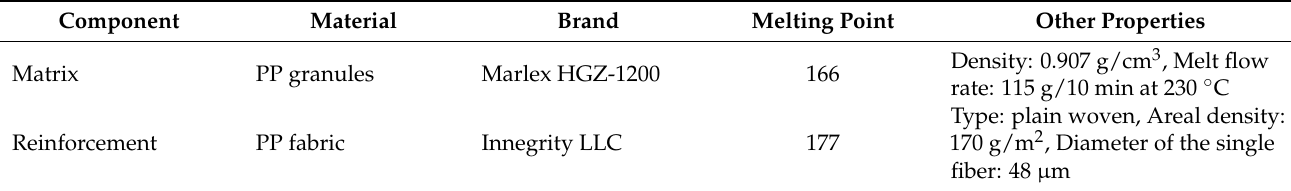
Table 1. Material information for the preparation of PP SPC